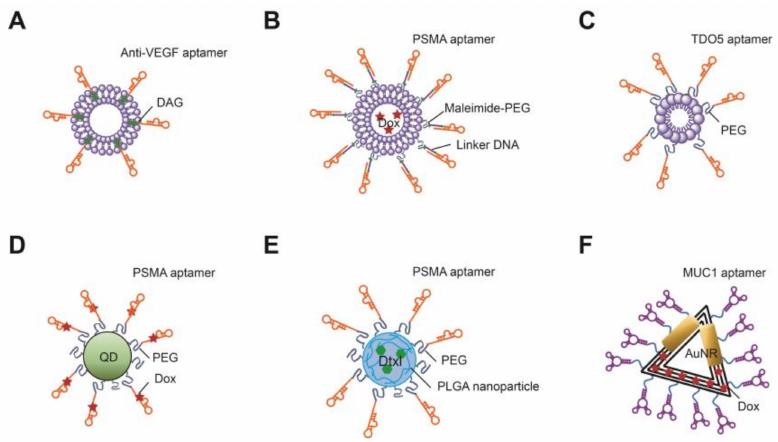
Figure 3. Schematics of aptamer nano-vehicle conjugates. ( A ) Aptamer-conjugated liposome. NX213 aptamers are directly conjugated with liposomes; ( B ) An aptamosome. A PSMA aptamer is annealed to linker DNA and conjugated with liposomes to form Dox-encapsulating “aptamosomes”; ( C ) Aptamer-micelle conjugate. A TDO5 aptamer is conjugated with a PEG-modified lipid to form aptamer-functionalized micelles; ( D ) Aptamer-nanoparticle conjugate. A Dox-encapsulated PSMA aptamers is conjugated with a quantum dot; ( E ) Aptamer-polymeric nanoparticle conjugate. An aptamer is conjugated with a PLGA nanoparticle containing docetaxel; ( F ) Aptamer-DNA origami conjugate. MUC1 aptamers are conjugated with DNA origami harboring gold nanorods and